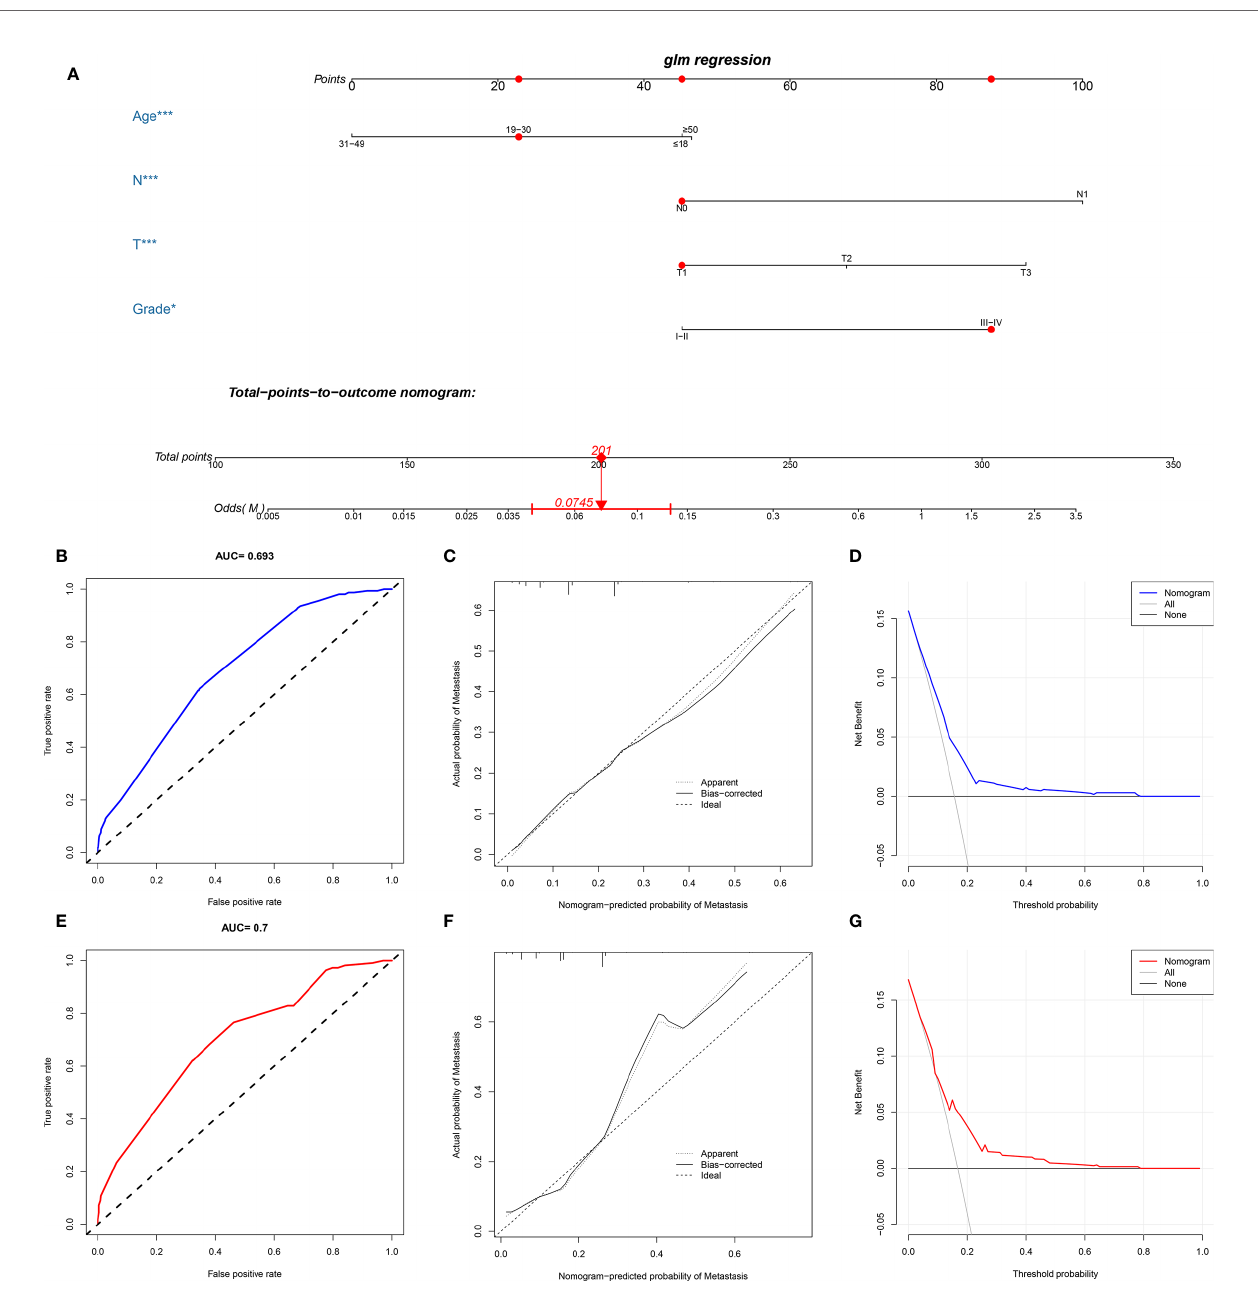
FIGURE 1 | Construction and validation of a diagnostic nomogram. A nomogram to estimate the risk of DM in osteosarcoma patients (A) . The receiver operating characteristic curve (B) , calibration curve (C) , and decision curve analysis (D) of the training set, and the receiver operating characteristic curve (E) , calibration curve (F) , and decision curve analysis (G) of the validation